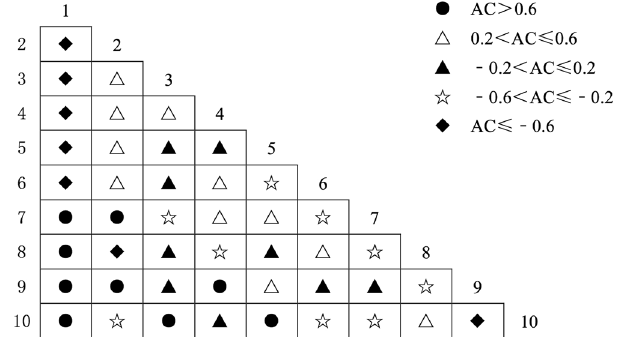
Figure 4. Half-matrix-diagram (AC Value) of interspecific association in Community II. Note: 1: Pinus tabulaeformis, 2: Quercus wutaishansea, 3: Lacquer tree, 4: Pyrus betulaefolia, 5: Betula platyphylla, 6: Populus